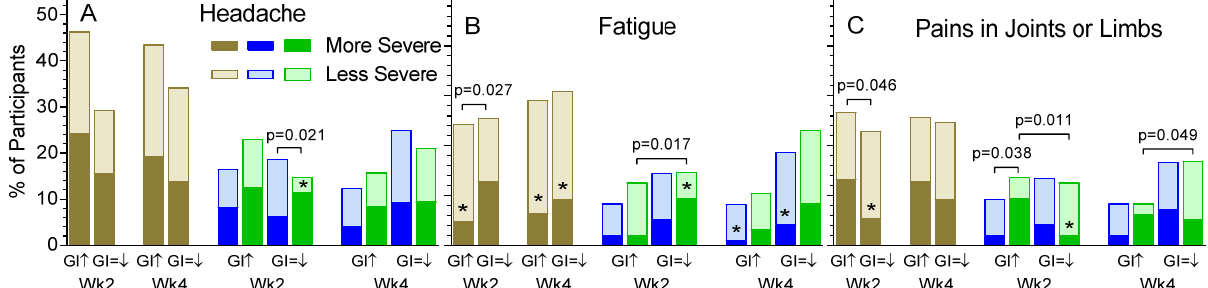
Figure 4. Effect of changes in GI symptoms on the severity of the non-GI symptoms headache ( A ), fatigue ( B ) and pains in joints or limbs ( C ). Bars show the percent of participants whose non-GI symptoms became more severe (dark bars) or less severe (light bars) during treatment for those whose GI symptoms (sum of scores for flatulence, diarrhea, constipation, abdominal distention, and abdominal pain) became more severe (GI ↑ ) or not (GI = ↓ ) during treatment. The percent of participants with no change in severity is not shown. Brown bars show all participants, blue bars Test and green bars Control. p -values are the significance of the difference between the ratios of More:Less severe for the bars indicated (e.g., panel A , in participants whose GI symptoms did not become more severe after 2 weeks treatment, Headache was more severe on Control vs. Test p = 0.021). * Ratio of more:less severe differs significantly from 1:1 by chi-square test ( p < 0.05). Table 1. Association of non-GI symptoms with major GI symptoms.